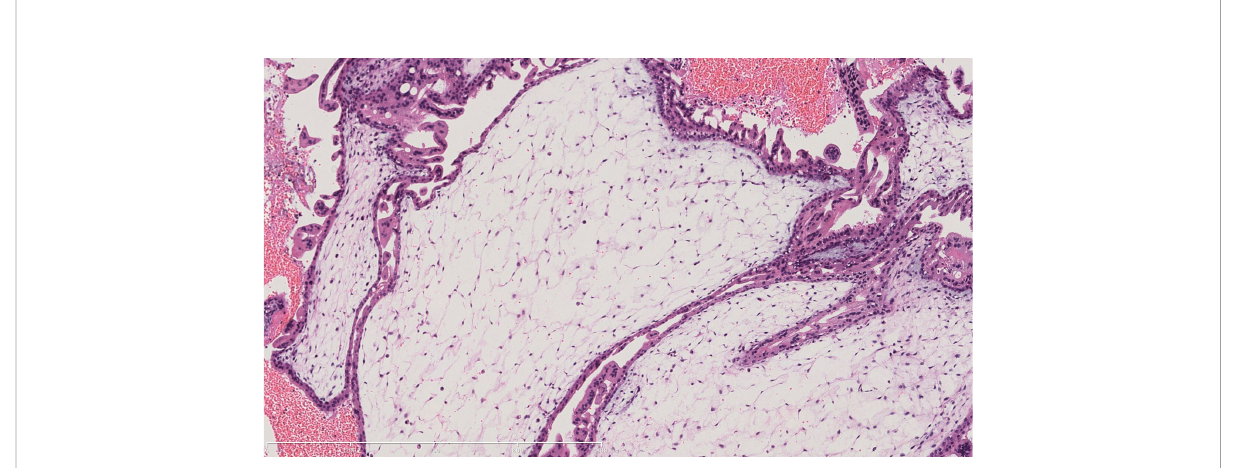
FIGURE 2 Pathological characteristic of the invasive mole. A representive image of HE staining demonstrating villi edema and trophoblast cells proliferation.